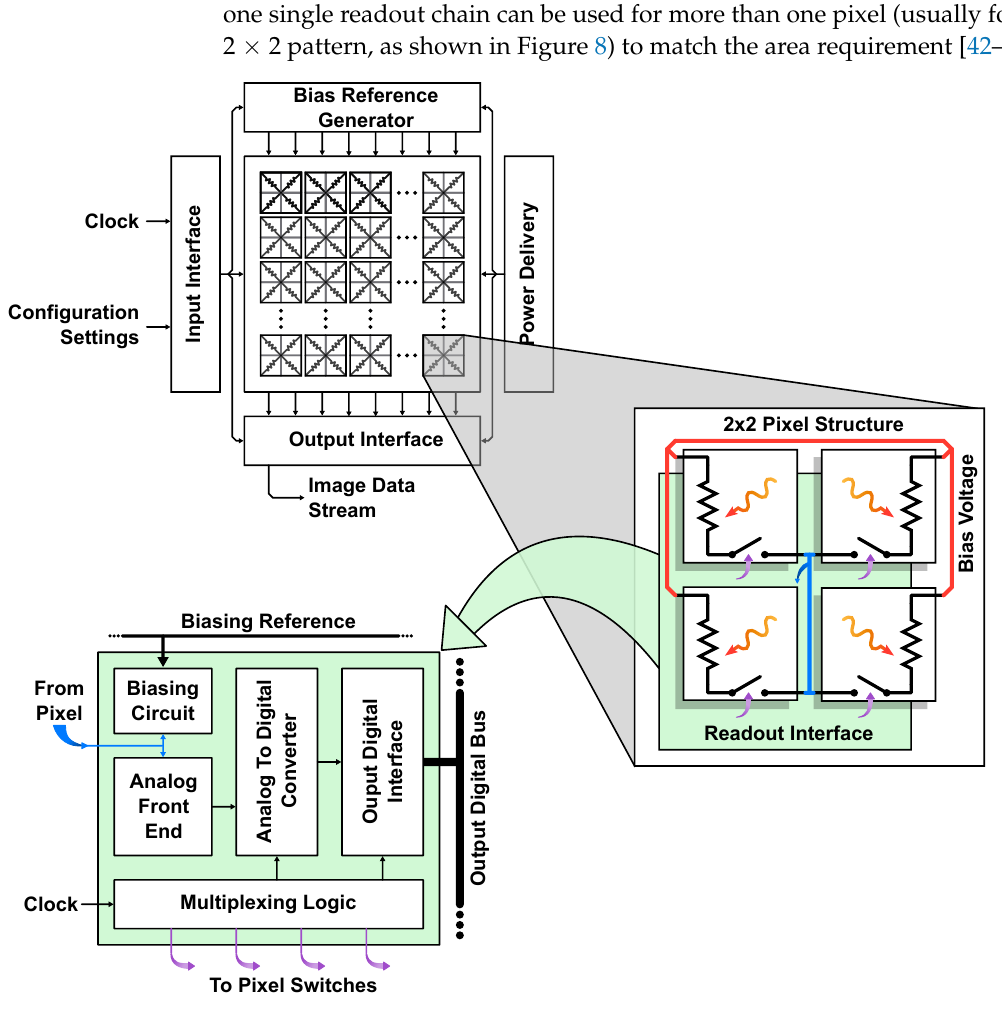
Figure 8. Pixel-wise readout scheme with a magnified view of the pixel